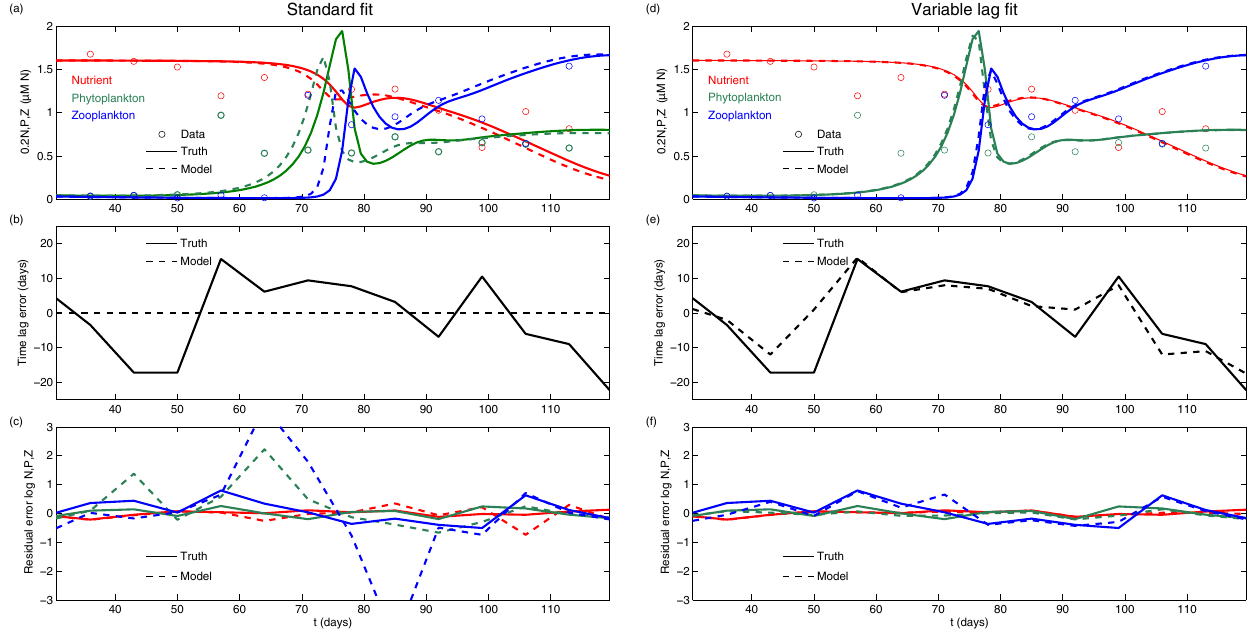
Figure A1. Demonstration of the variable lag fit (VLF) applied to a simulated data set. (a, d) show the system trajectory with the true parameter values (solid lines), the data (dots) simulated assuming normal and independent time lag errors ( σ τ = 10 days) and residual errors ( σ log N,P,Z = 0.1, 0.2, 0.3; see Table A1), and the system trajectory with the VLF parameter estimates (dashed lines) from the standard fit (a) and from the VLF (d) . (b, e) compare the true time lags (solid) with the modelled time lags (dashed) for the standard fit (b) and the VLF (e) . (c, f) compare the true residual errors (solid) with the model estimates (dashed) for the standard fit (c) and the VLF ( f , same colour code as in a , c ). Three years of data were assimilated, but only the initial and post-bloom period of the first year is shown for clarity.